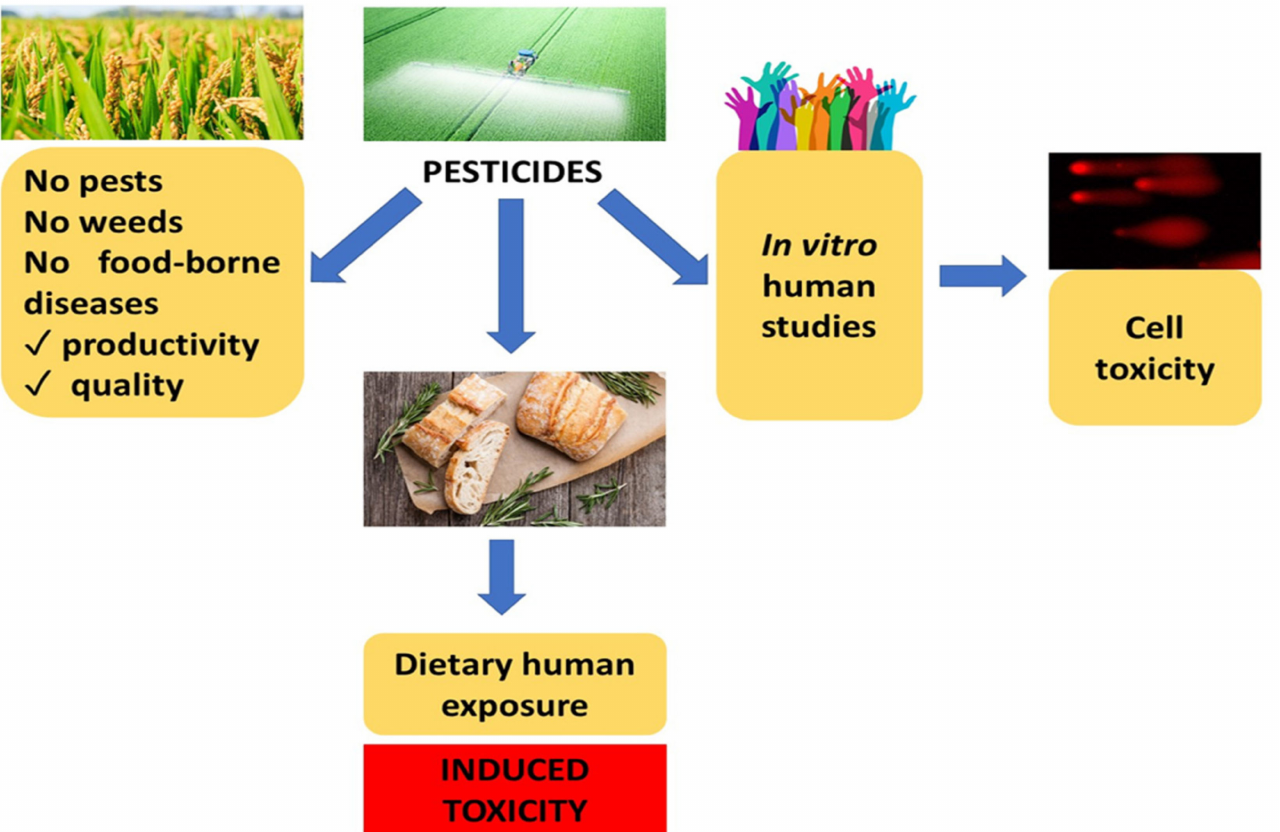
Figure 6. Positive and negative sides of pesticide use in